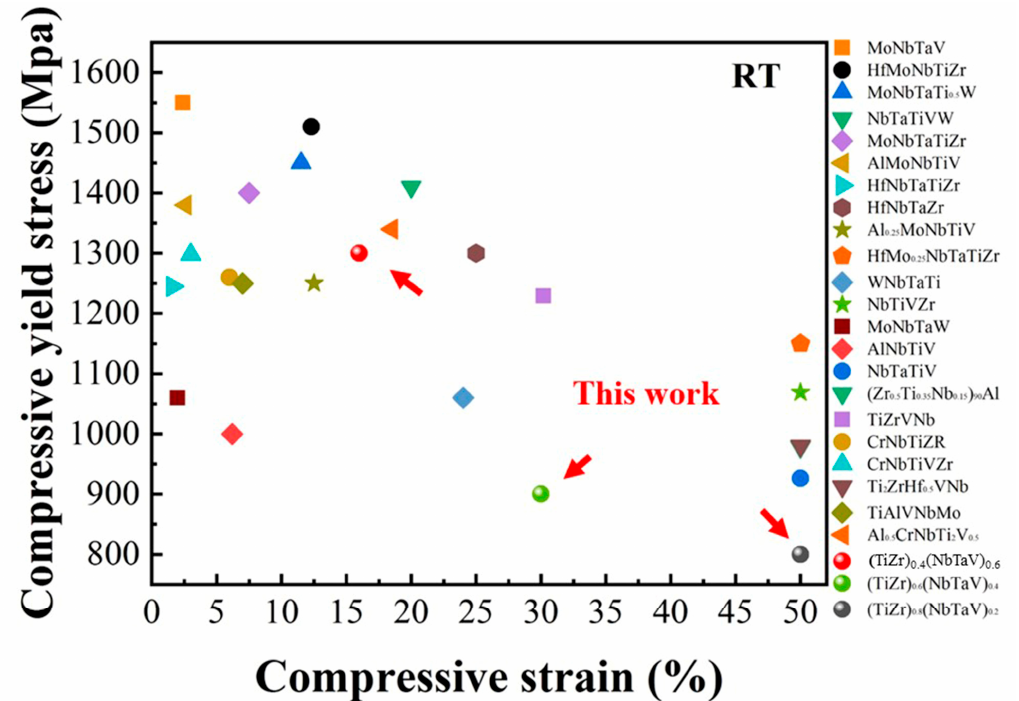
Figure 6. Compressive yield strength and plasticity of (TiZr) x (NbTaV) 1 − x RHEAs and some reported RHEAs at room temperature.